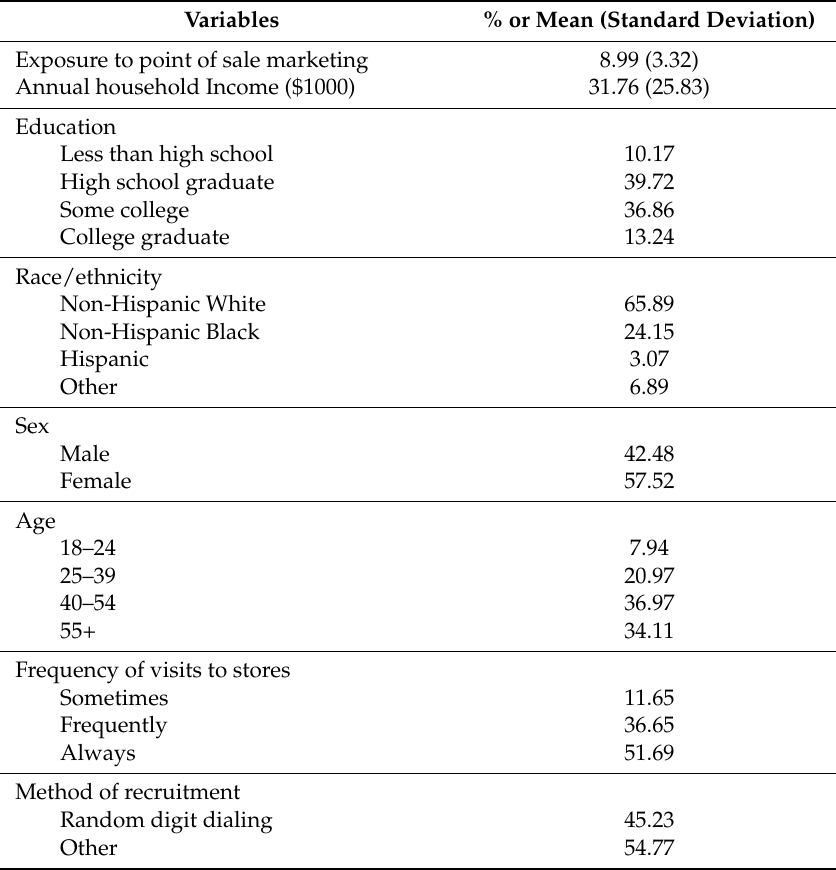
Table 1. Sample characteristics ( n =